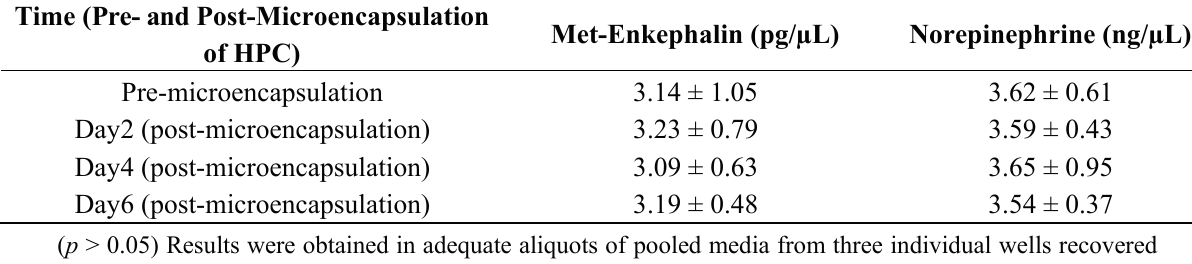
Table 1. The contents of met-enkephalin and norepinephrine in the cell culture media pre- and